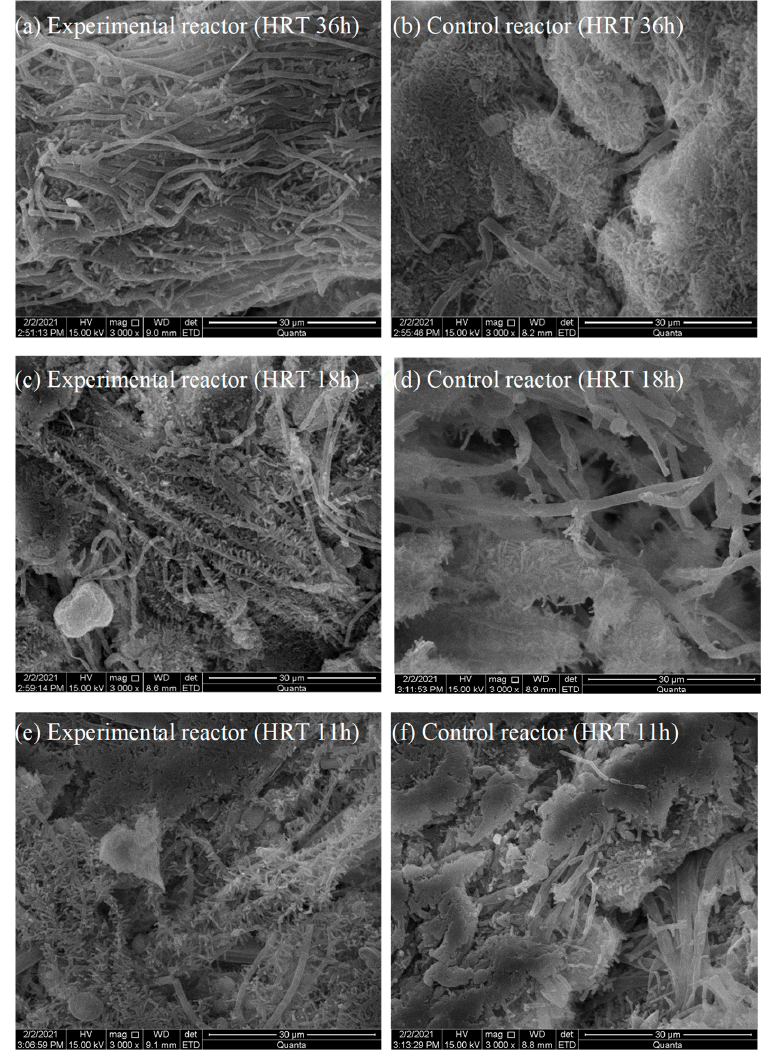
Figure 4. SEM of biofloc from both reactors under various HRTs.